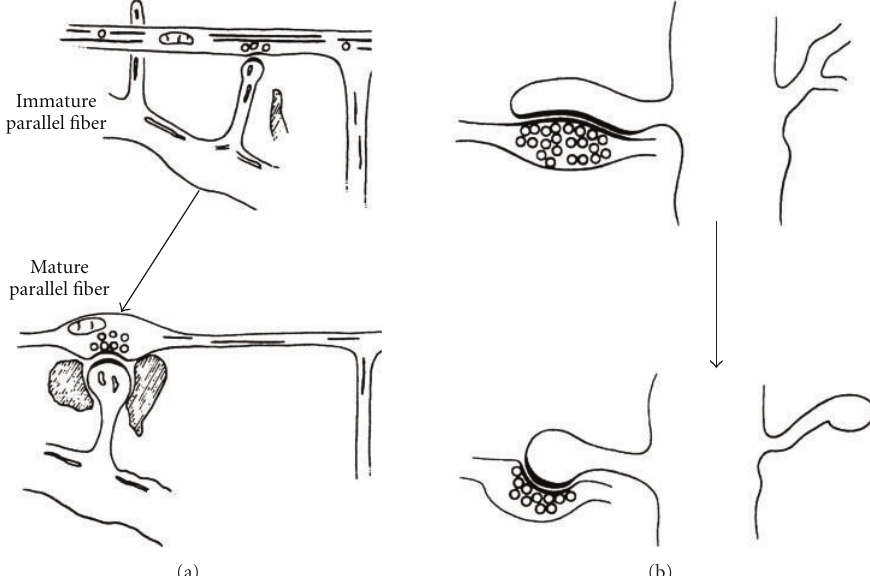
Figure 4: Spinogenesis in the Purkinje cell branchlets contacting parallel fibers according to Larramendi [15, Figures 4 and 5] using electron microscopy, 14-day-old mouse. (a) Dendrites grow “ long spine-like processes, ” once the synaptic contact occurs with a parallel fiber, spines develop a terminal head and the parallel fiber forms a swelling. (b) Parallel fibers often form long synaptic adhesions with developing spines that subsequently decrease in size ( synaptic adhesion waning